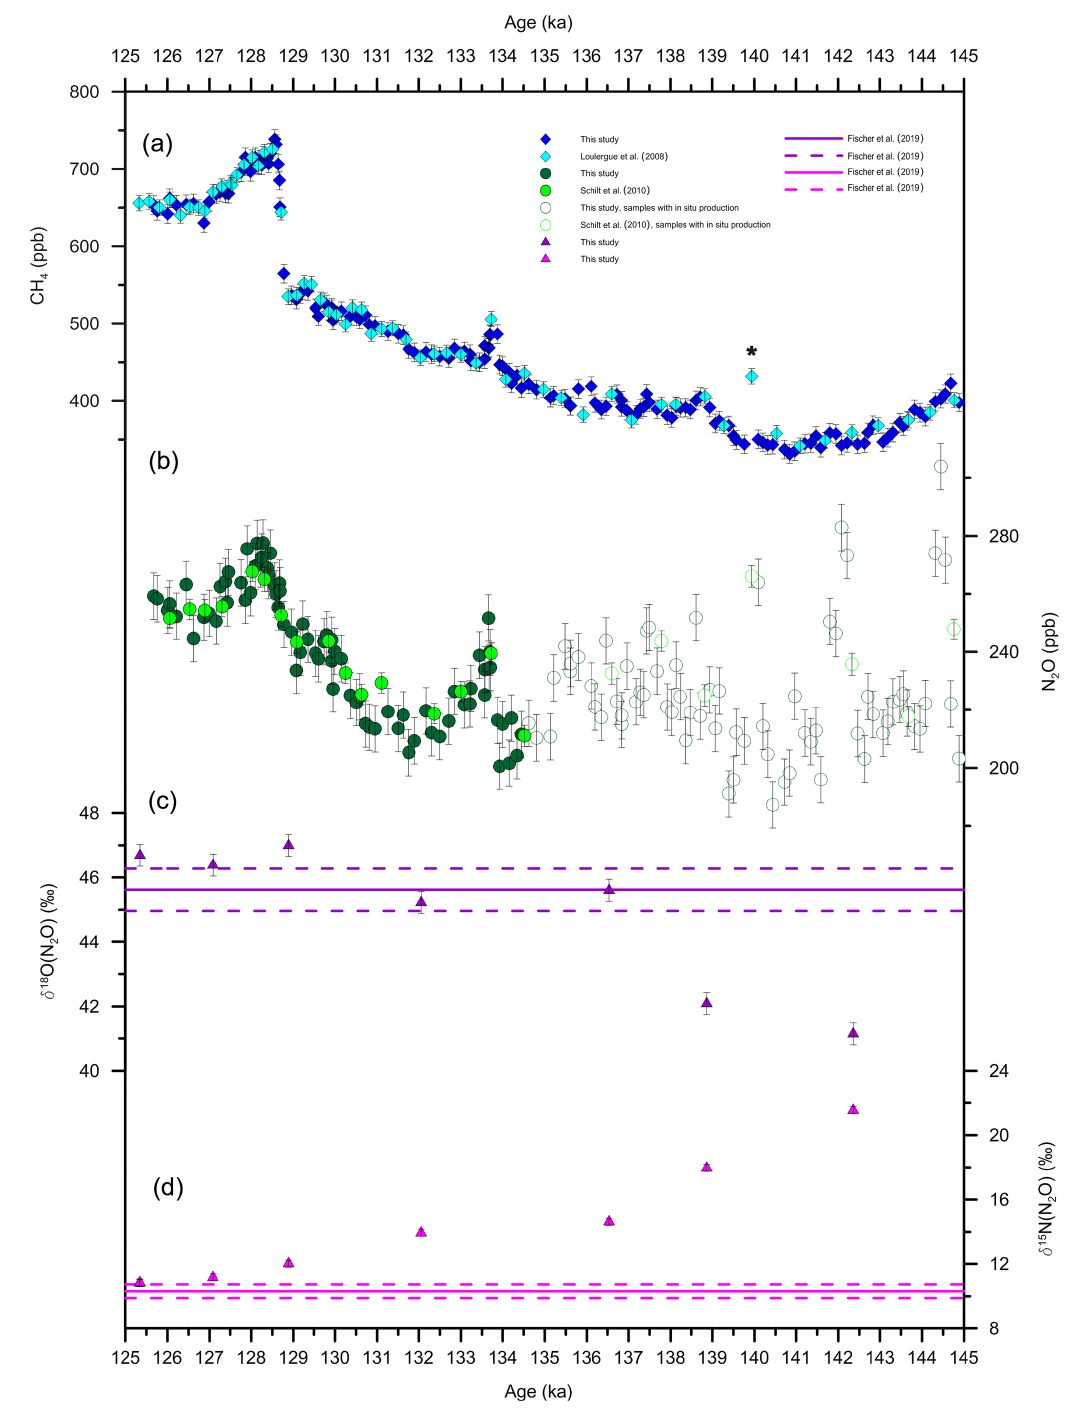
Figure 1. CH 4 , N 2 O, δ 18 O (N 2 O), and δ 15 N (N 2 O) records from the EDC ice core on the AICC2012 timescale (Bazin et al., 2013). The vertical bars represent the uncertainty of the measurements. (a) Composite CH 4 record with published data (light blue, Loulergue et al., 2008) and new measurements (this study, dark blue) after offset correction. The asterisk indicates the data point regarded as an outlier. (b) Composite N 2 O record with published data (light green, Schilt et al., 2010a) and new measurements (this study, dark green) after offset correction. The empty symbols illustrate the data points considered affected by in situ production. (c) δ 18 O (N 2 O) record. For comparison, the average (solid line) and standard deviation (dashed line, 1 σ ) of δ 18 O (N 2 O) over TI are included (Fischer et al., 2019). (d) δ 15 N (N 2 O) record. For comparison, the average (solid line) and standard deviation (dashed line, 1 σ ) of δ 15 N (N 2 O) over TI are included (Fischer et al.,